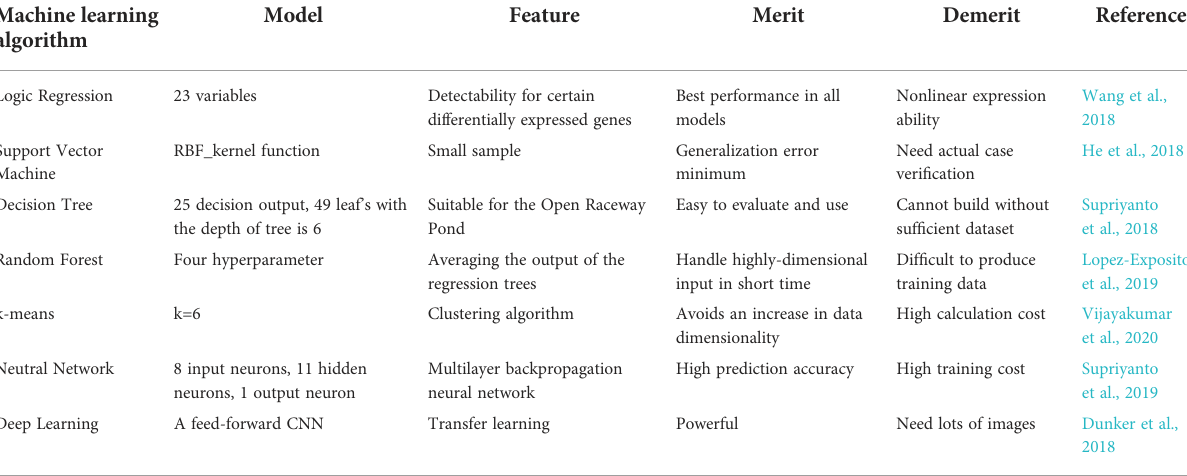
TABLE 4 Machine learning algorithms and models used in microalgae growth monitor. Machine learning